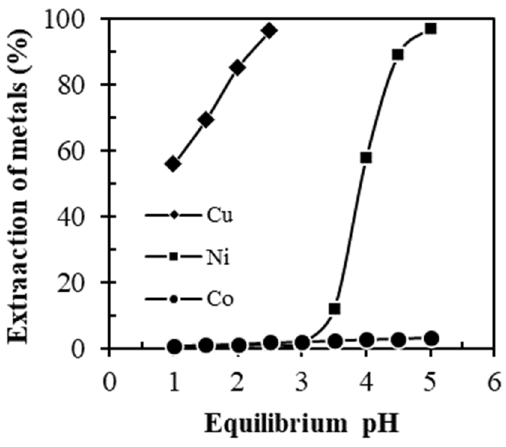
Figure 11. Solvent extraction of Cu, Ni and Co from leach liquor (Metals concentration in leach liquor